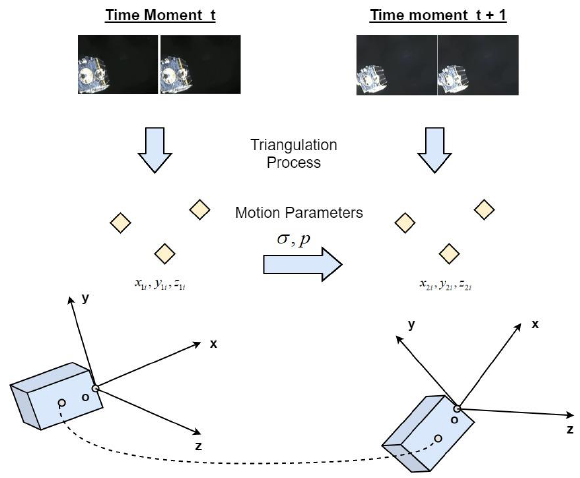
Figure 3 . Data processing with using stereo images.